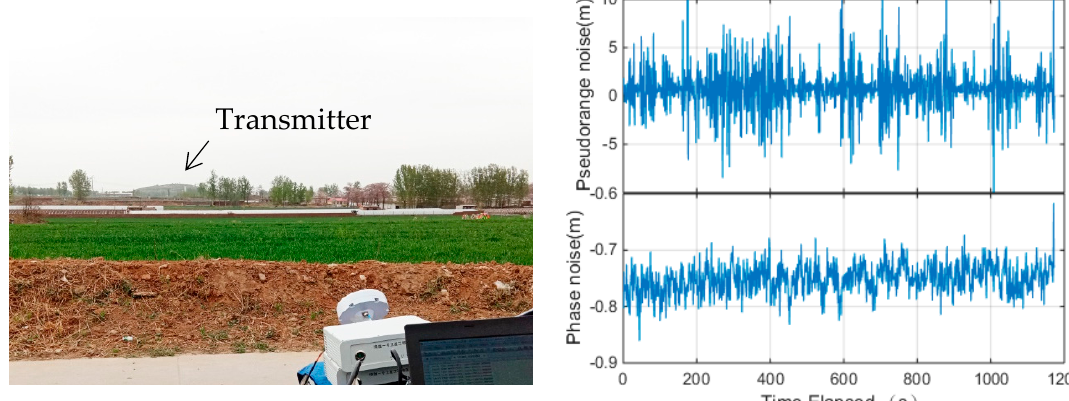
Figure 3. Ground assessment of the Luojia-A ranging measurements: the test scenario ( left panel ) and measured signal samples ( right panel ).